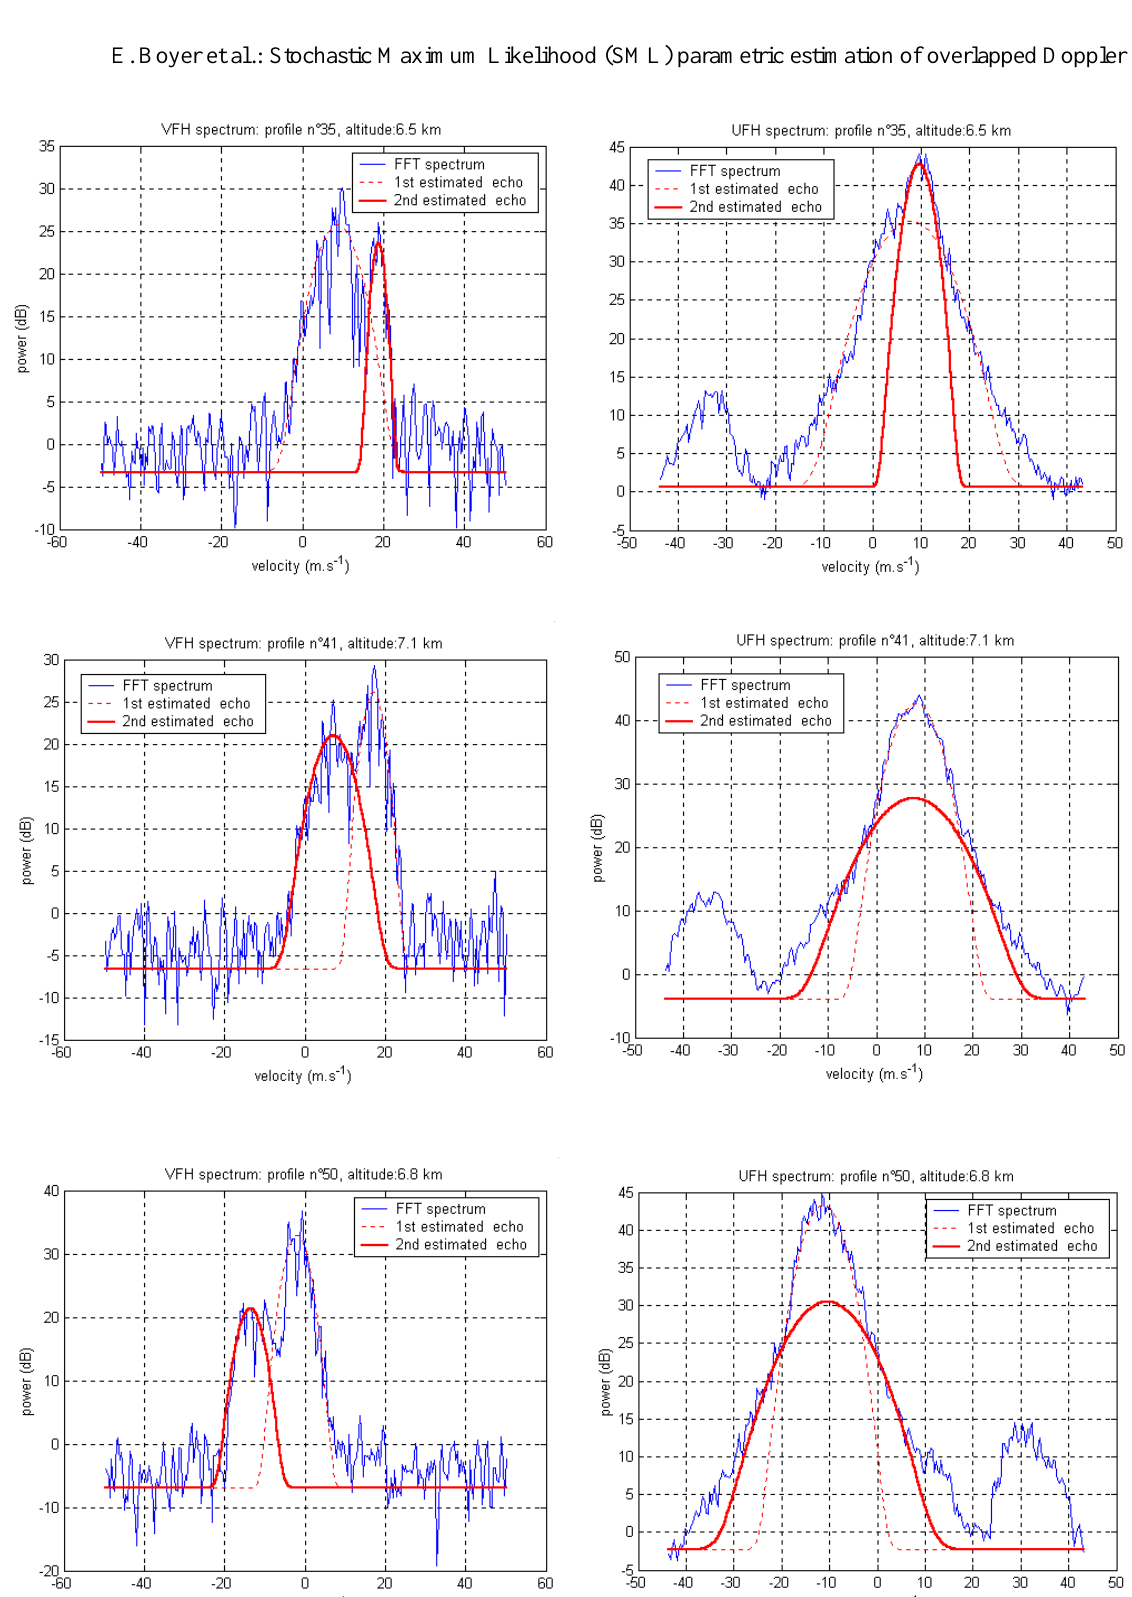
Fig. 9. SML estimation of air and hydrometeor echoes for a few profiles located in the strong updraft area (the algorithm as not yet affected the type of the